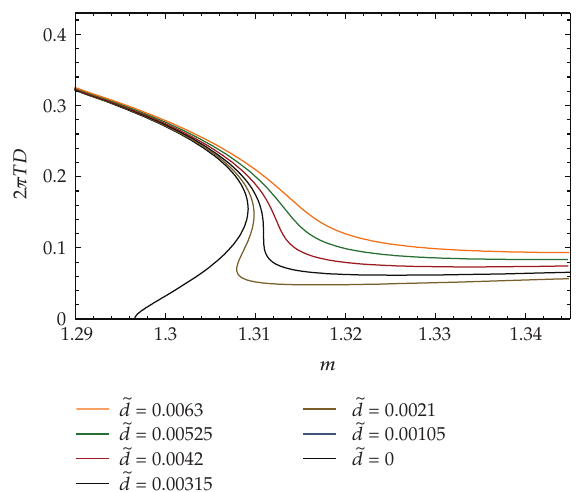
Figure 18: The normalized baryon di ff usion coe ffi cient as a function of normalized inverse temperature. (cid:11) At densities below d (cid:5) 0 . 00315 we observe a multivalued dependence on m , signaling a phase transition. For the behavior of the coe ffi cient in a larger range of m see Figure